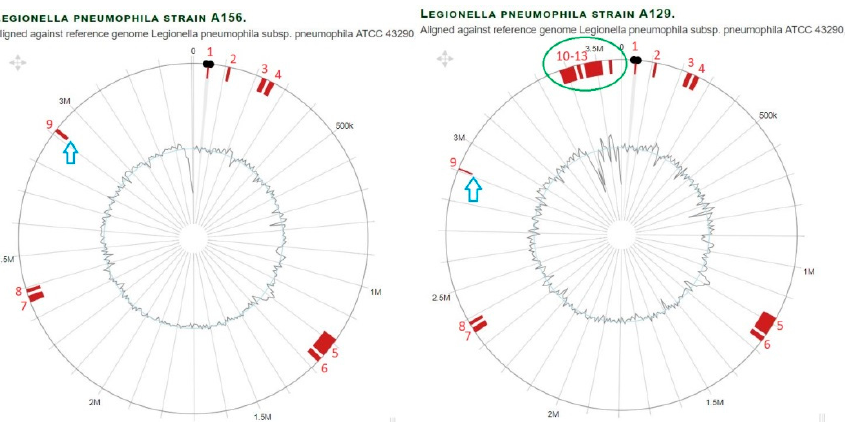
Figure 4. Comparison of genomic islands in branch Philadelphia of L. pneumophila strain A129 and A156 aligned against reference genome L. pneumophila strain Philadelphia1. With regard to the outer layers, the circle shows: (i) nucleotide positions in Megabase pairs (Mbp) (black); (ii) Island-Viewer-annotated potential genomic islands (GI) are labeled accordingly (red); (iii) extra GIs (marked by green oval); (iv) GI with different sizes (blue arrow).